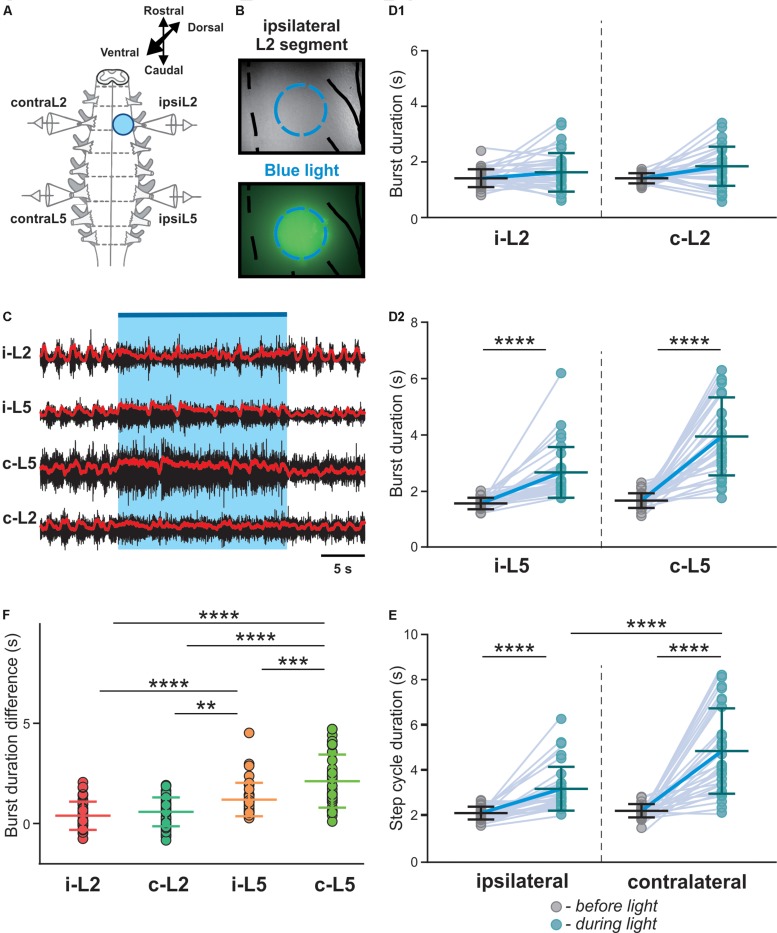
Biased optical activation of V3 interneurons in spinal segment L2 and corresponding changes in ENG characteristics in spinal segment L2 and L5 during drug-induced locomotor-like activity. (A) Illustration of experimental setup for recording motor activity evoked by optical stimulation on the left spinal segment L2 from ventral side during drug-evoked fictive locomotion. (B) Image of the optical stimulation area. Black dashed line represents the midline of spinal cord. Blue dashed circle illustrates the light illuminated region. Black line on the right shows the frame of Nerve L2 and lateral edge of the spinal cord. (C) Recording trace during optical stimulation. Biased optical activation of V3 interneurons in spinal segment L2 leads to asymmetrical left-right extensor motor activity. Blue bar and area indicate the stimulation period. Red lines are rectified and smoothed traces of the original ENG recordings (black). (D1,D2) Average of burst duration of L2 (D1) and L5 (D2) during drug-induced locomotor-like activity (n = 33) before (gray circles) and during (blue circles) optical stimulation in ipsilateral and contralateral cord. (E) The average of step cycle duration of ipsilateral and contralateral L5 activities during drug-induced locomotor-like activity (n = 33) before (gray circles) and during (blue circles) optical stimulation. Light blue lines connecting two circles represent change in one cord. Thick, dark blue line represent the average of change. **** indicates P < 0.0001. (F) Average of locomotor burst duration difference between before and during biased optical stimulation. ∗∗ indicates 0.001 < P < 0.01, ∗∗∗ indicates 0.0001 < P < 0.001, **** indicates P < 0.0001; n = 33.